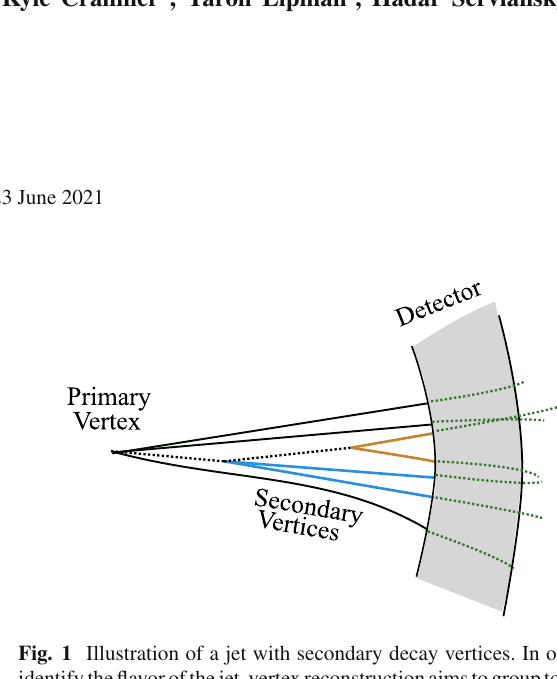
Vertex reconstruction can be separated into two tasks, ver- tex finding , and vertex fitting [2]. Vertex finding refers to